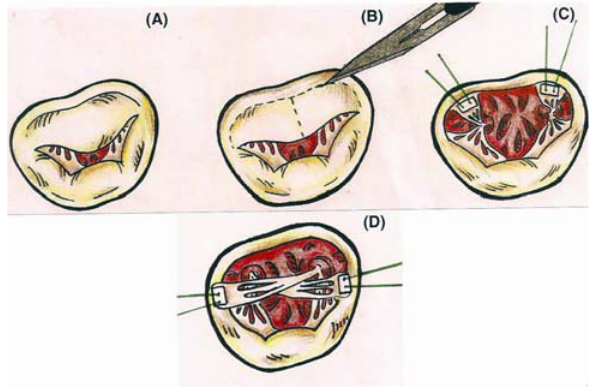
Fig. 1 - Papilopexia cruzada - A. Valva nativa. B. Desinserção da cúspide anterior. C. Pontos na metade da cúspide anterior. D. Papilopexia